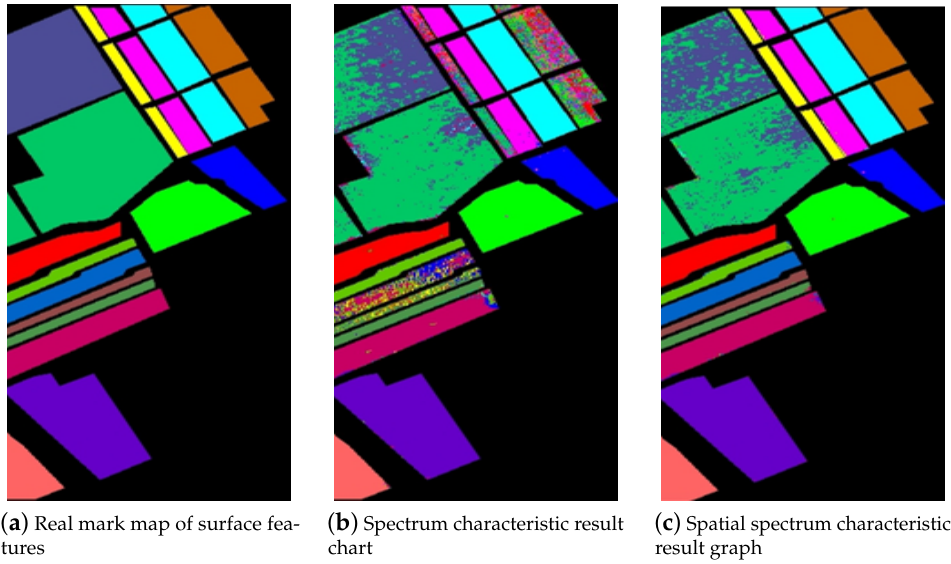
Figure 11. Classification results of Salinas